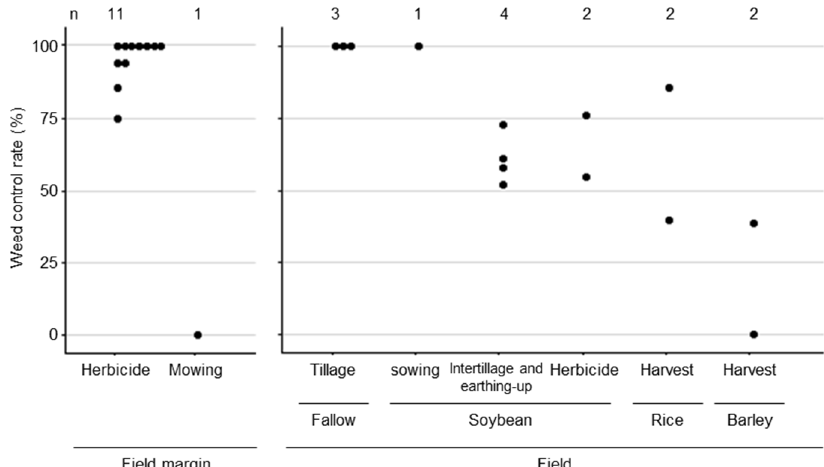
Figure 1. Weed control rate by agricultural practices in the fields and their margins. One bullet shows the weed control rate by one practice. Bullets are shown using a horizontal jitter display. Fields and survey years are not distinguished in this figure. Fallow refers to the post-harvest conditions for rice and barley. Weed control rates for practices such as puddling with a harrow, rice transplanting and herbicide treatment, soybean harvesting, and barley sowing and herbicide treatment are not shown because entireleaf morning glory did not exist just before the practice. Values at the top of the figure represent the number of practices in the two